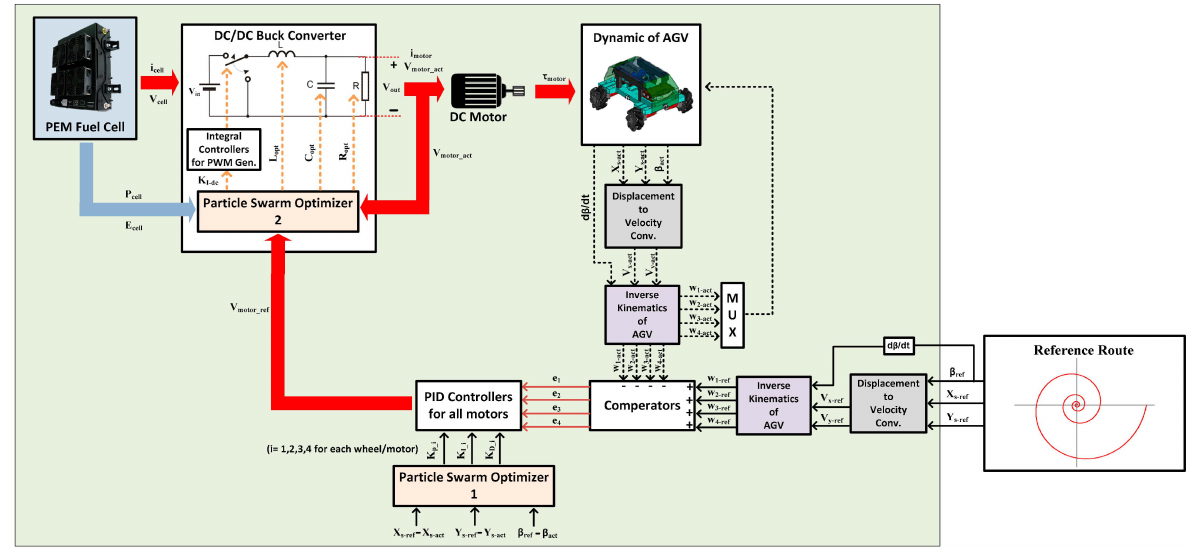
Figure 1. The schematic diagram of the four-Mecanum-wheeled AGV system.